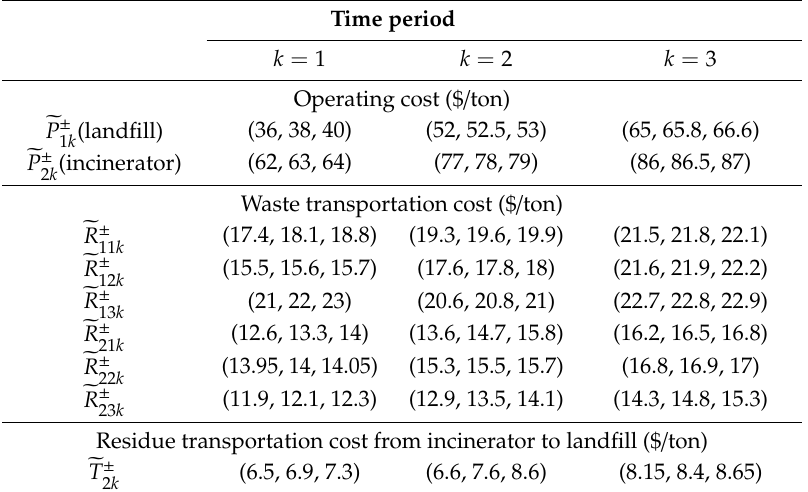
Table 1. Operating and transportation cost.